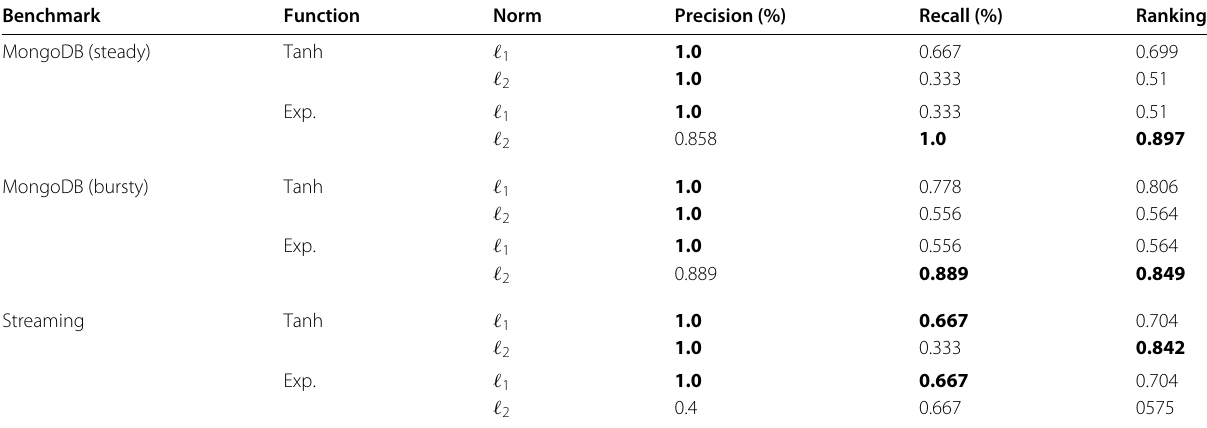
Table 3 WISE Score validation results using benchmark performance metrics Benchmark